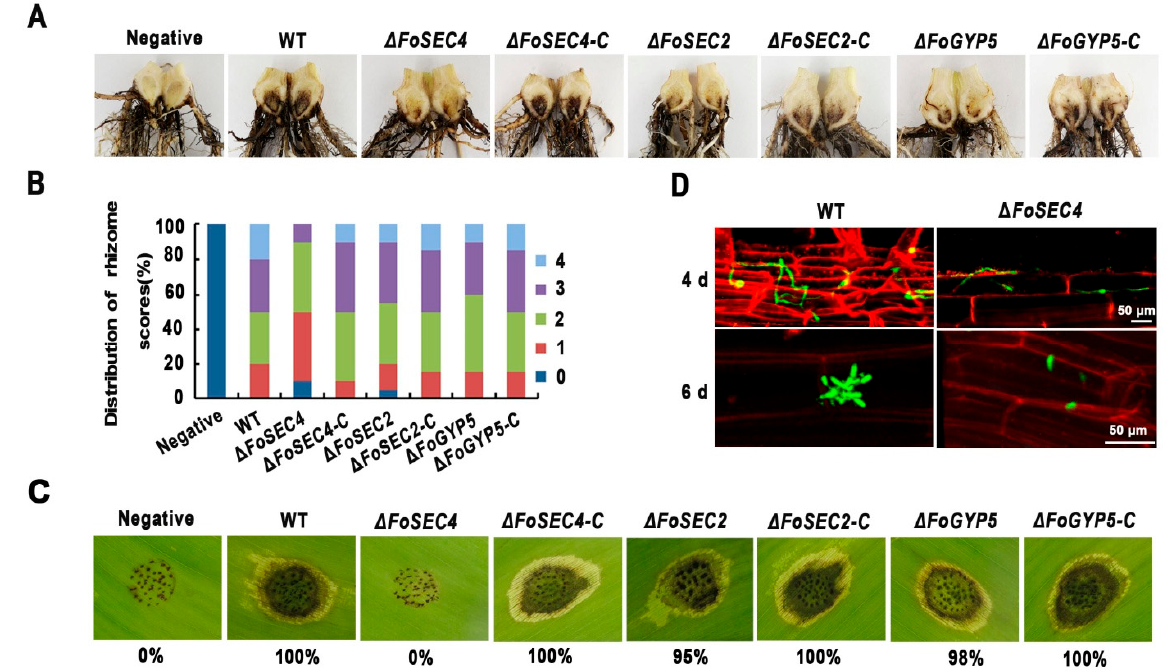
Figure 5. Pathogenicity of the wild-type (WT), ∆ FoSEC4 , ∆ FoSEC2 , ∆ FoGYP5 , ∆ FoSEC4-C , ∆ FoSEC2-C and ∆ FoGYP5-C strains. ( A ) Disease symptoms on the corms of banana tissue plantlets were recorded 2 months after inoculation with the indicated strains and negative control water. ( B ) The percentage of plants in each disease index was scored for corm symptoms as follows: 0 represents no browning in the corm, 1 represents browning in 1% to 25% of the area in the corm, 2 represents browning in 25% to 50% of the area in the corm, 3 represents browning in 50% to 75% of the area in the corm, and 4 represents browning in 75% to 100% of the area in the corm. ( C ) Necrosis spots on banana leaves were recorded 5 days after inoculation with the indicated strains and negative control water. The bottom numbers indicate the relative size of necrotic tissue caused by the indicated strains compared with the WT strain. ( D ) Confocal images of the WT-GFP and ∆ FoSEC4 -GFP strains growing inside banana roots 4 and 6 days after inoculation. Bar = 50 μ m.